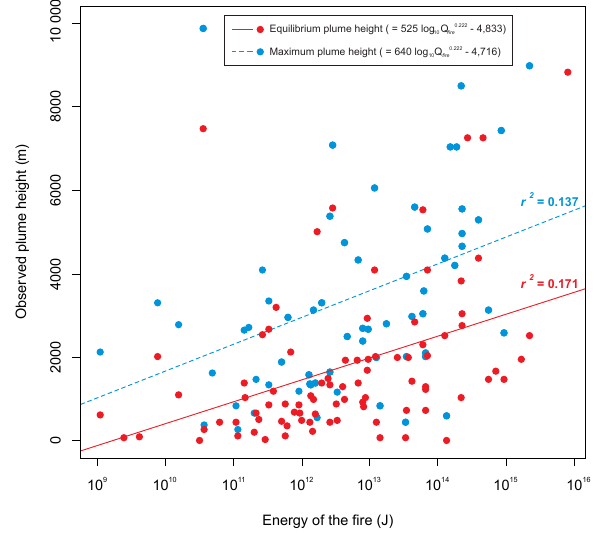
Figure 6. Energy of the fire (J) on a logarithmic scale compared with observed equilibrium and maximum plume heights (m). Cor- relation coefficients shown next to trend line; regression equations shown in the